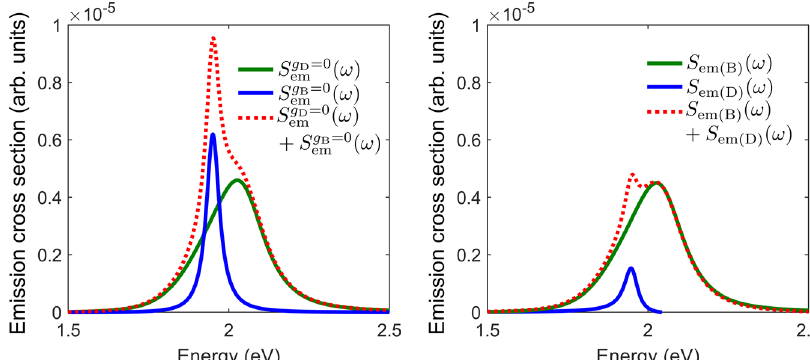
Fig. 5 Quantum simulations of the plasmon-QD emission spectrum. a Numerically calculated emission spectra of the system for g D ¼ 0, S g D ¼ 0 em ω ð Þ (green line), for g B ¼ 0, S g B ¼ 0 em ω ð Þ (blue line), and sum of the two, S g D ¼ 0 em ω ð Þ þ S g B ¼ 0 em ω ð Þ (red dotted line). b Analytically calculated contributions to the emission spectrum due to the bright exciton, S em B ð Þ ω ð Þ (green line), dark exciton, S em D ð Þ ω ð Þ (blue line), and the total analytical spectrum containing both contributions, S em ω ð Þ ¼ S em B ð Þ ω ð Þ þ S em D ð Þ ω ð Þ (red dotted